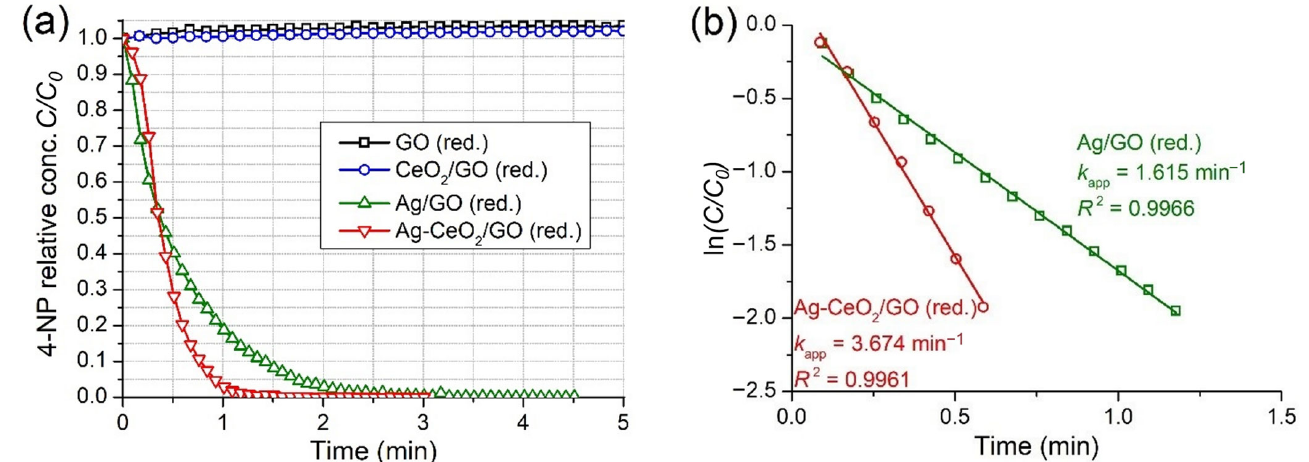
Figure 9. Kinetic curves of 4-NP reduction over the pre-reduced samples ( a ) and the pseudo-first-order plot of the 4-NP relative concentration logarithm ln( C / C 0 ) versus the reaction time for the Ag/GO (red.) and Ag-CeO 2 /GO (red.) catalysts ( b